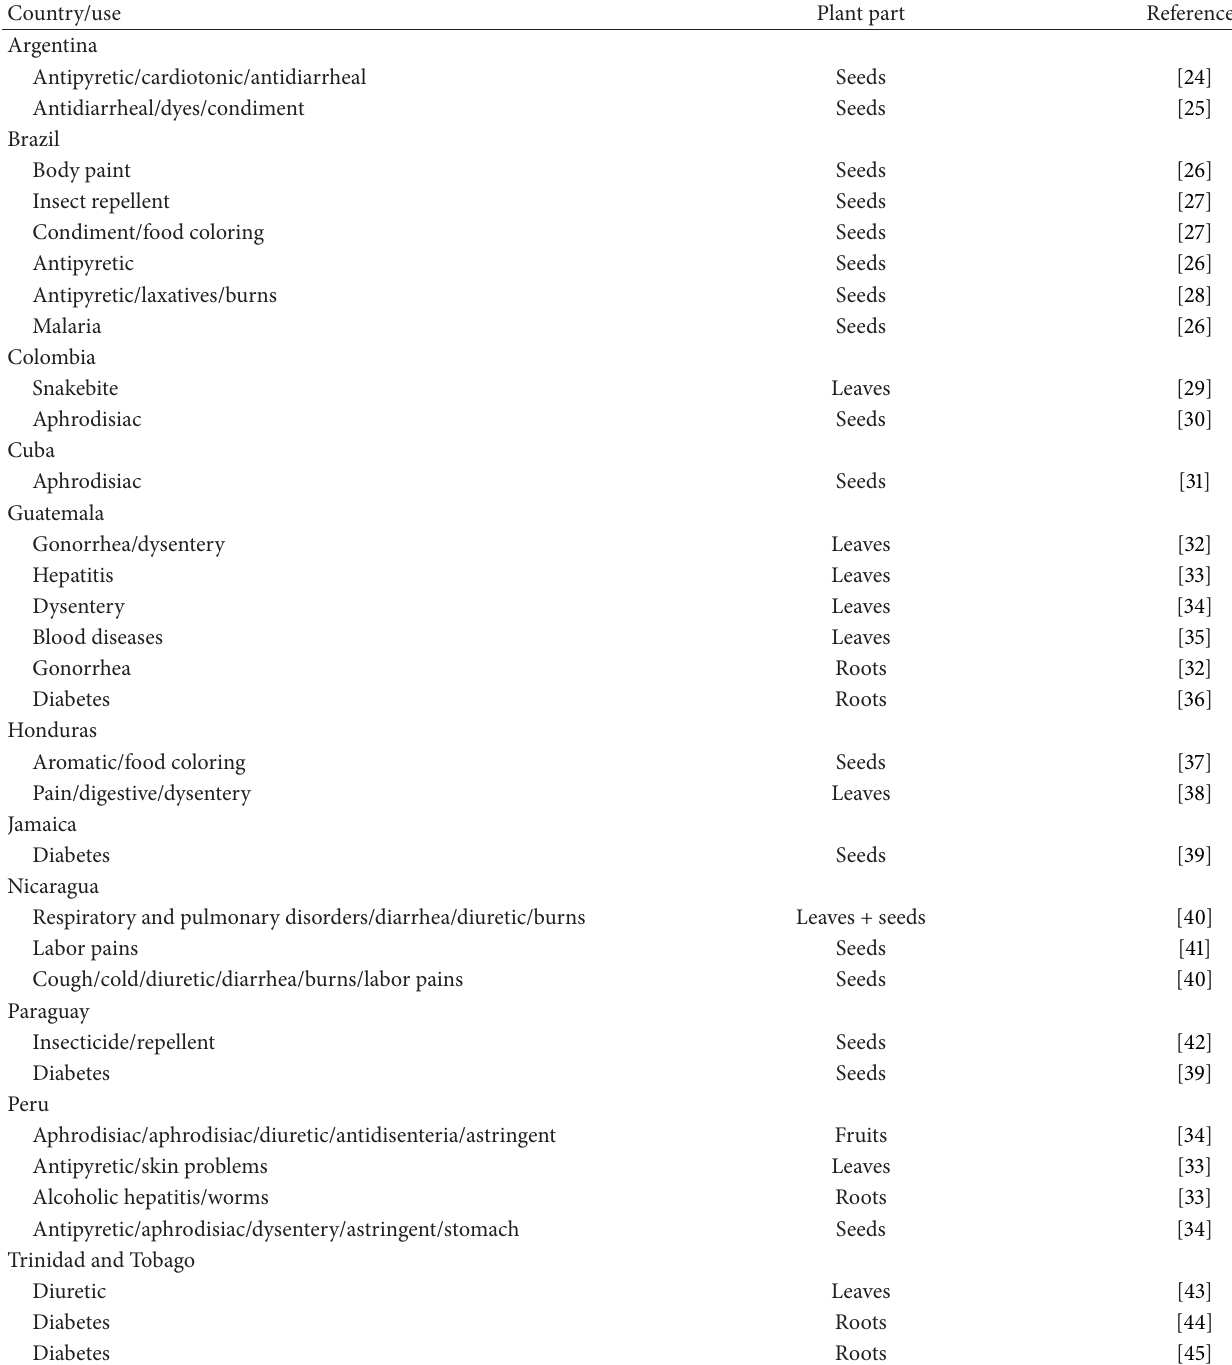
Table 1: Traditional uses of annatto in American